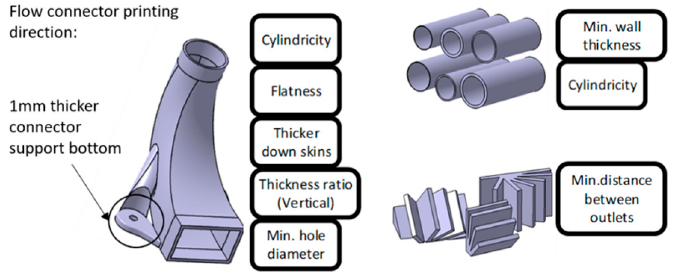
Figure 5. Test artifacts to assess LPBF manufacturing constraints in relation to the flow connector geometry.